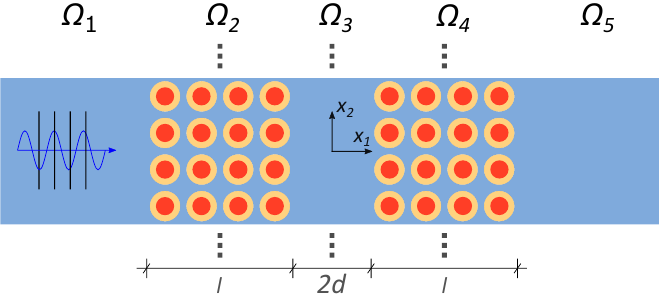
Figure 1. Top-view of the studied system. The wave shown in the figure represents an out-of-plane wave propagating throughout all the five domains. The dots denote the fact that the system must be extended along the x 2 direction.